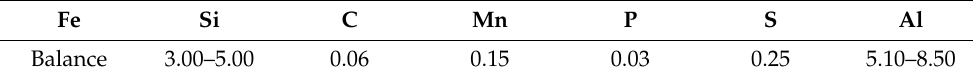
Table 1. Chemical components of the silicon steels expressed as weight percentages.